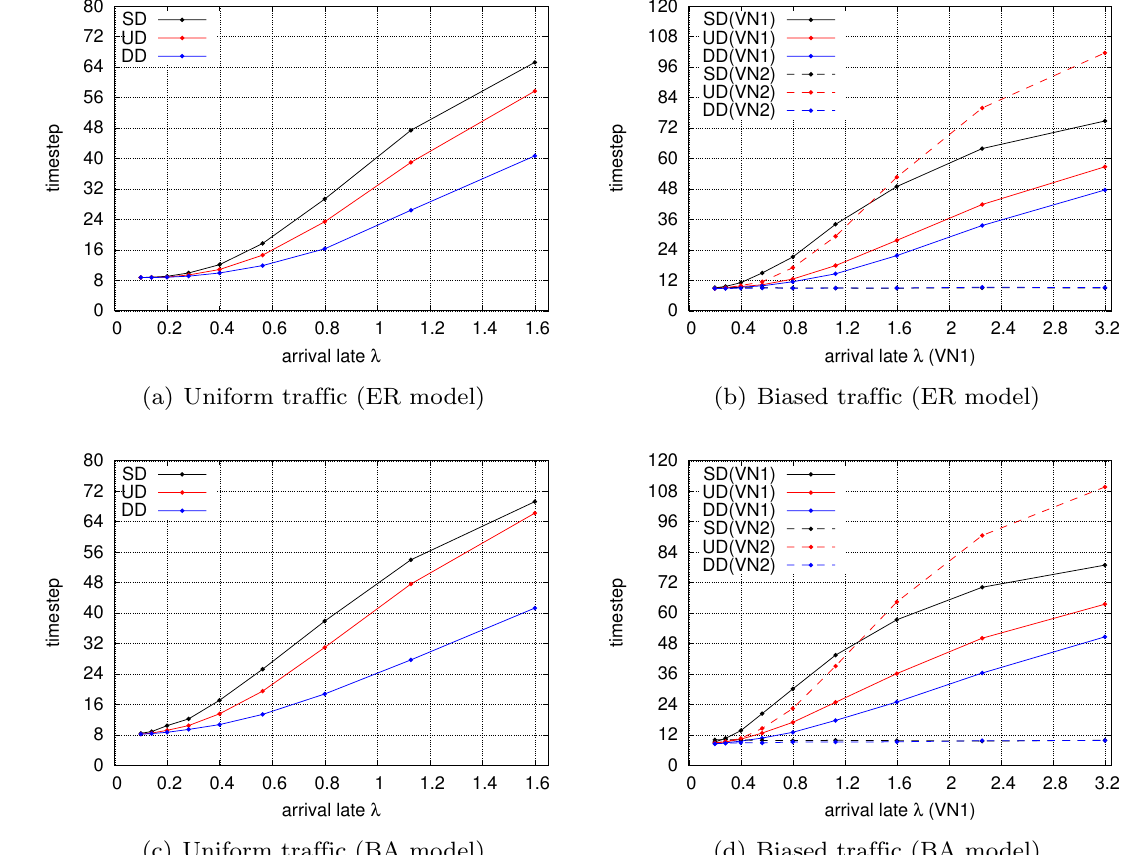
Figure 5. Variation of packet delay with arrival rate λ . The vertical axis represents the packet delay, required time steps for a packet to be transmitted. Similarly to Figure 4, the solid lines in ( a , c ) correspond to the average packet delay of the two VNs, whereas the packet delays for each VN are plotted separately in ( b , d ). The horizontal axis represents the arrival rate λ . In ( b , d ), note that λ is changed on VN1 but fixed on